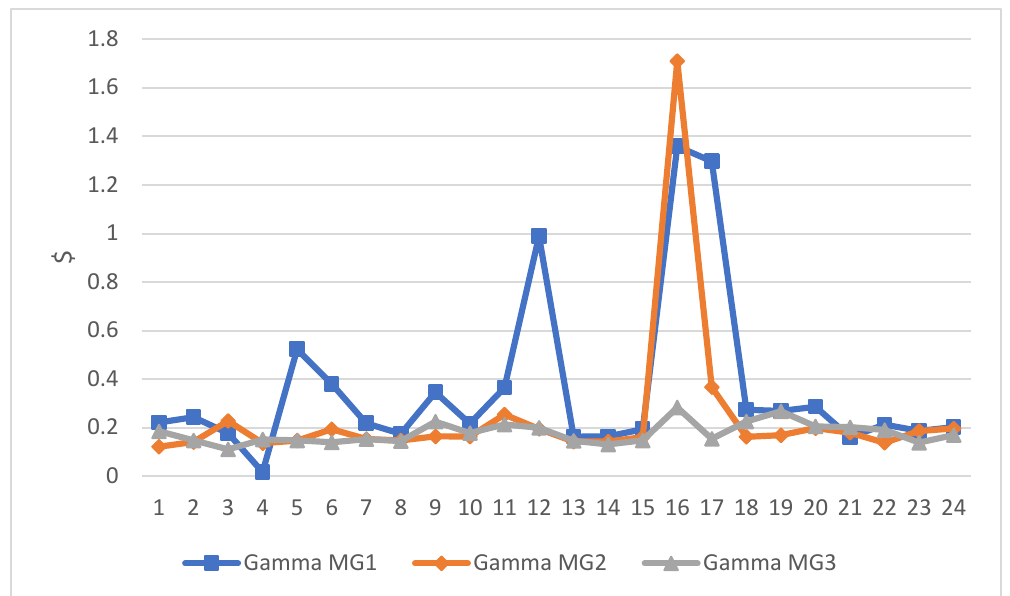
Figure 16. Change in the energy sale prices of each microgrid to consumers.